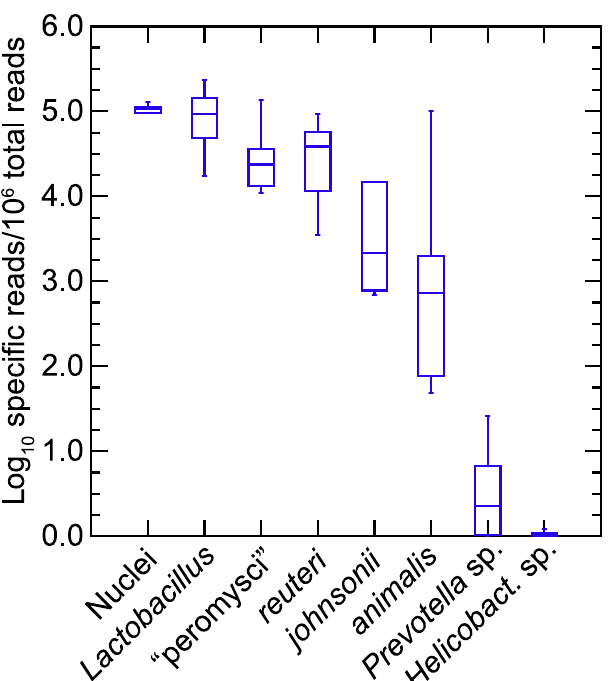
Fig 13. Box-whisker plots of log-transformed normalized reads of total metagenomes of the stomachs of 9 P . leucopus that mapped to chromosomes of Lactobacillus spp. or other bacteria by host species and by sex. The references to which reads were mapped were complete chromosomes or partial chromosomes of organisms listed in Table 1. “ Lactobacillus ” in the first position of each panel were the cumulative reads for the four individual Lactobacillus species in this analysis. The number of cell “nuclei” present in the stomach tissue and DNA extract were estimated by mapping reads to the whole genome of P . leucopus as described in the